Question: What kind of plot is shown here?
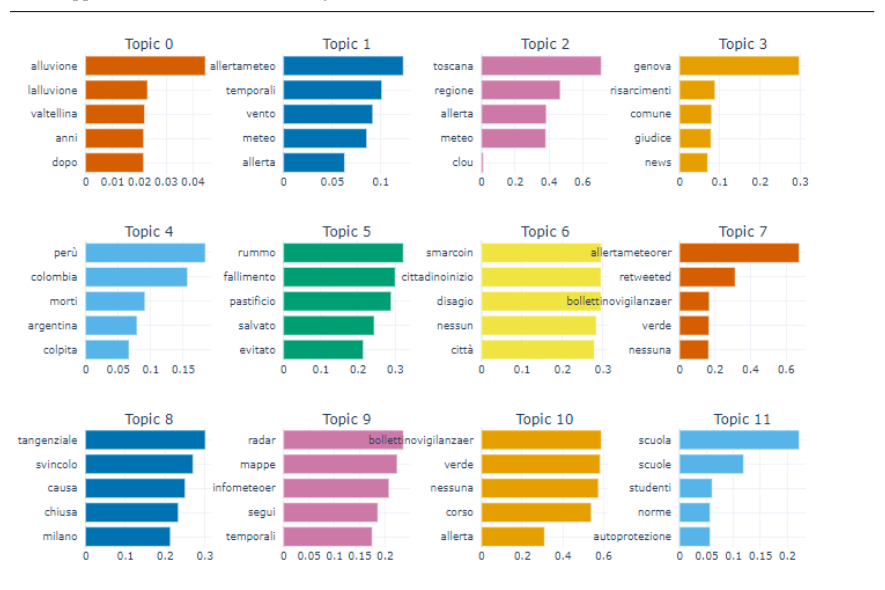
Answer: bar